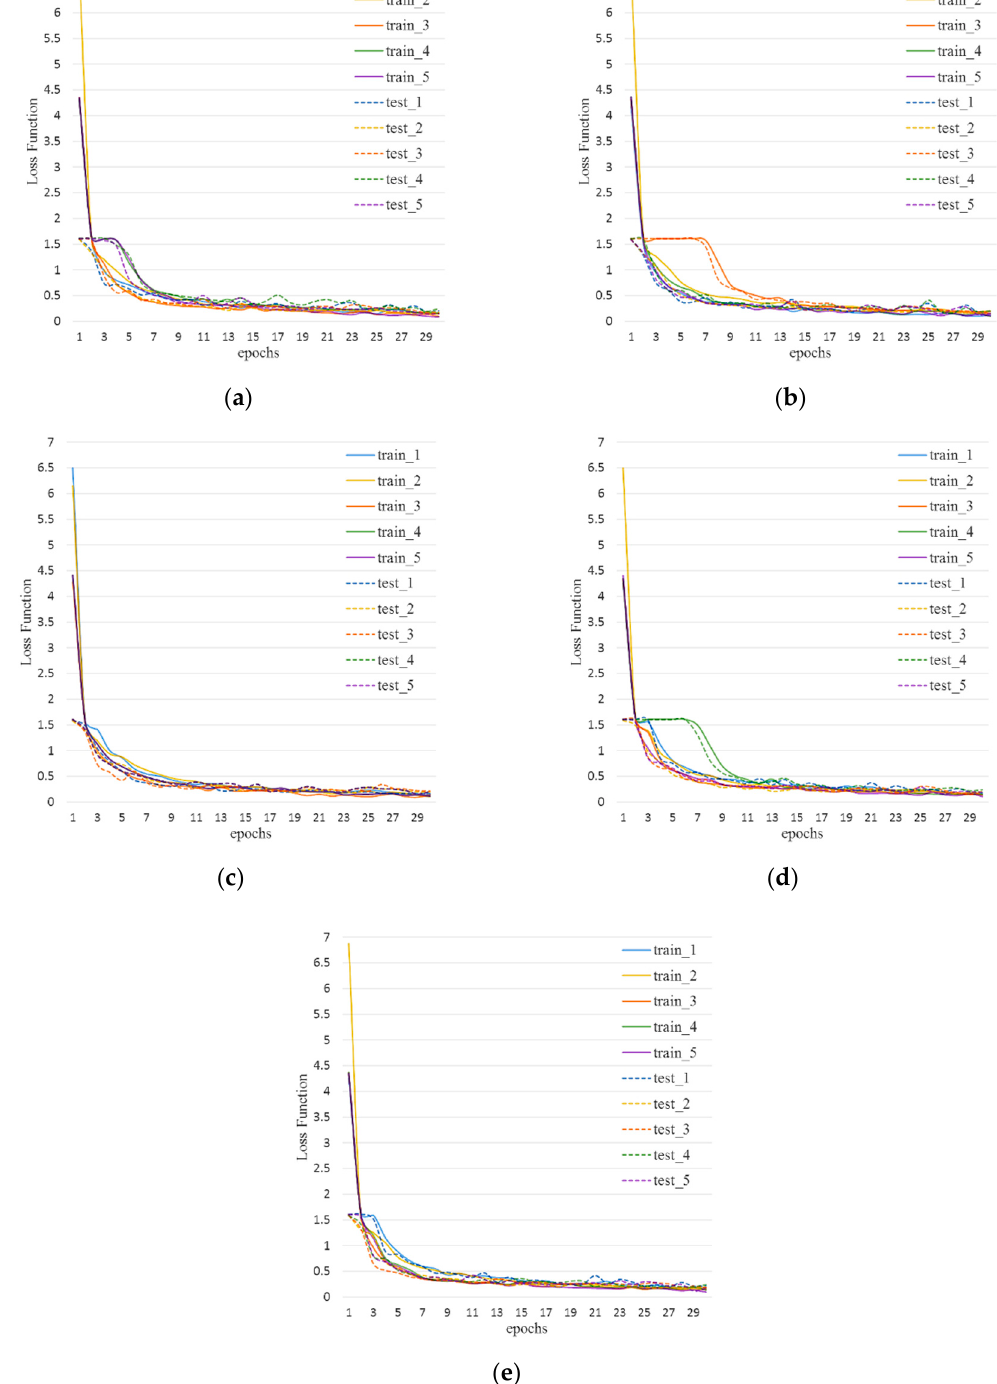
Figure 11. Five train–test categorical cross entropy (CCE) loss function graphs ( a – e ) of five motor loading conditions, respectively, with five train–test runs of cross-validation.